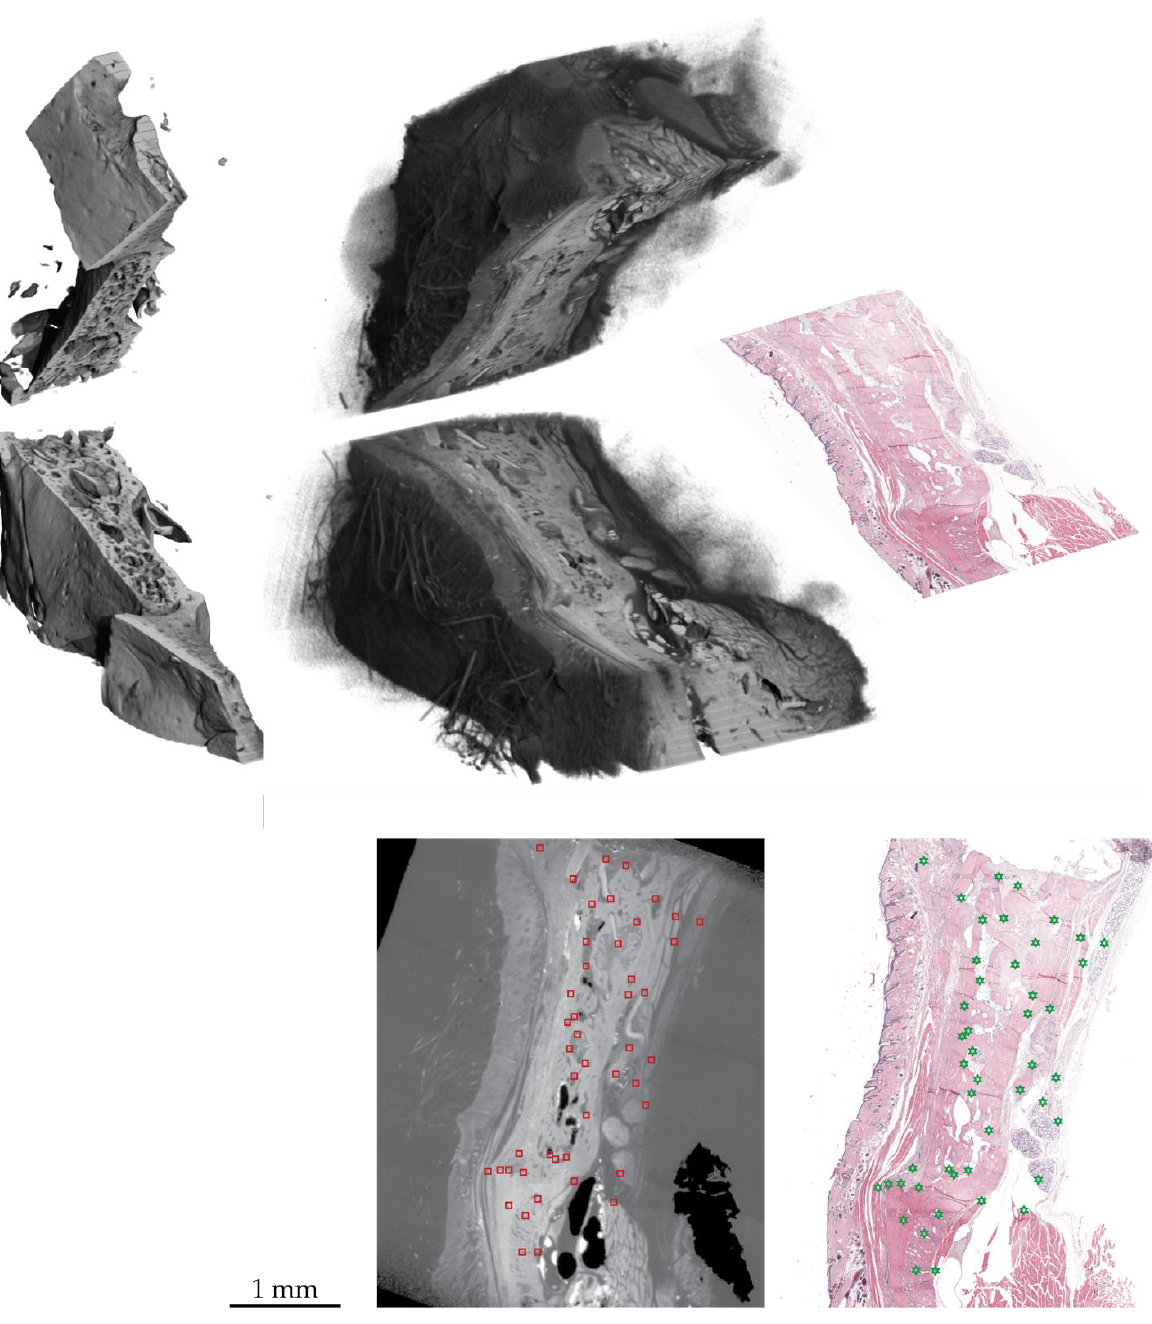
Figure 8. Location of the selected histology slice within the tomography data, see top row. In a first step, the approximate location was identified manually. In a second step, landmark pairs, i.e., SRµCT and histology slices, guide surface extraction and 2D-2D pre-registration. An automatic non-rigid 2D-2D registration refines correspondences.